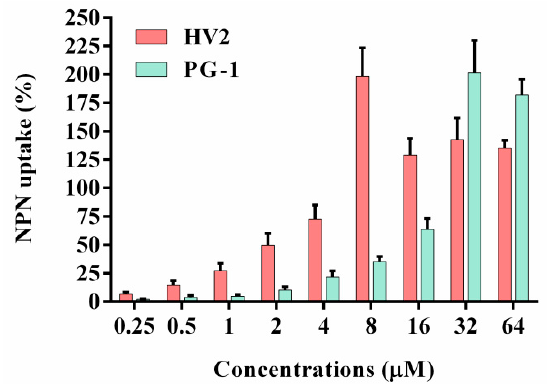
Figure 6. Outer membrane permeabilization assays of HV2 and PG-1. The uptake capacity of different concentrations of peptides to the NPN of E. coli ATCC 25922 was evaluated using a fluorescent dye (NPN) assay. The NPN uptake was monitored at an excitation wavelength of 350 nm and an emission wavelength of 420 nm. Polymyxin B was used as a positive control for its strong outer membrane permeability properties.